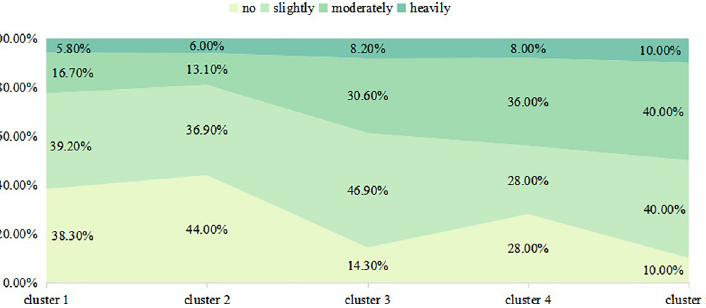
Fig 6. The relationship between threatened cognitive types and the amount of maternal anxiousness regarding antenatal care during the coronavirus